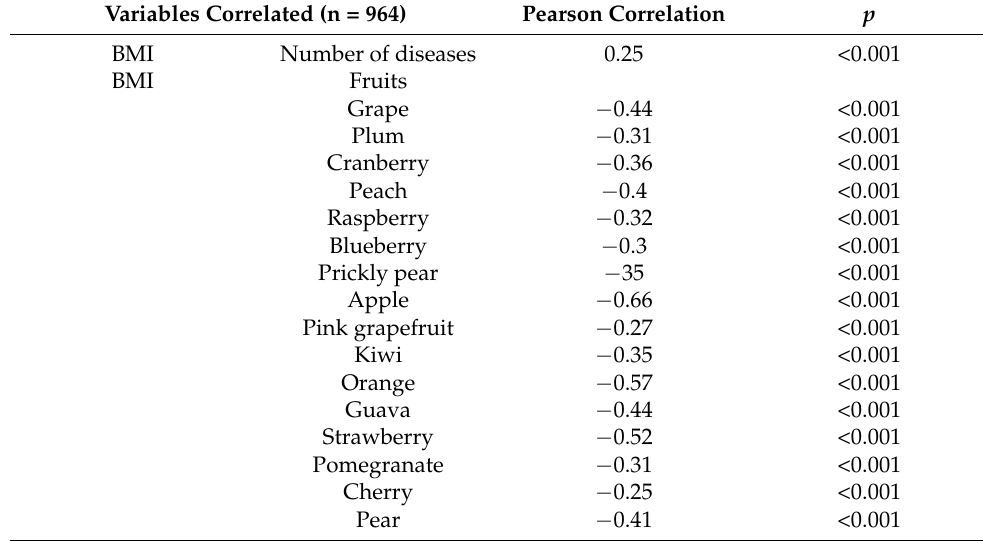
Table A5. Illustrates correlations between the BMI and number of diseases and BMI and PCI of each